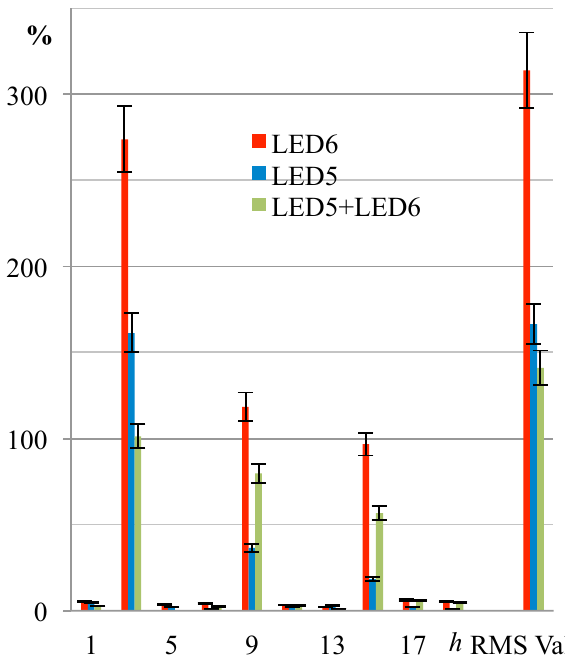
Figure 8: Harmonic currents content in the neutral conductor of a four–core cable for a selected LED–LED combination. current of the combination is strongly reduced with respect of the third–order harmonic current, although some important to note that the current of the LED6 has a strong emission limit imposed by IEC as quoted in Section 1) and also of high–order harmonics ( h = 9 and 15). As the overall harmonic power losses in the neutral conductor depend on the RMS value of the total current, a marked reduction in the harmonic losses with respect to that of the LED6 (and even